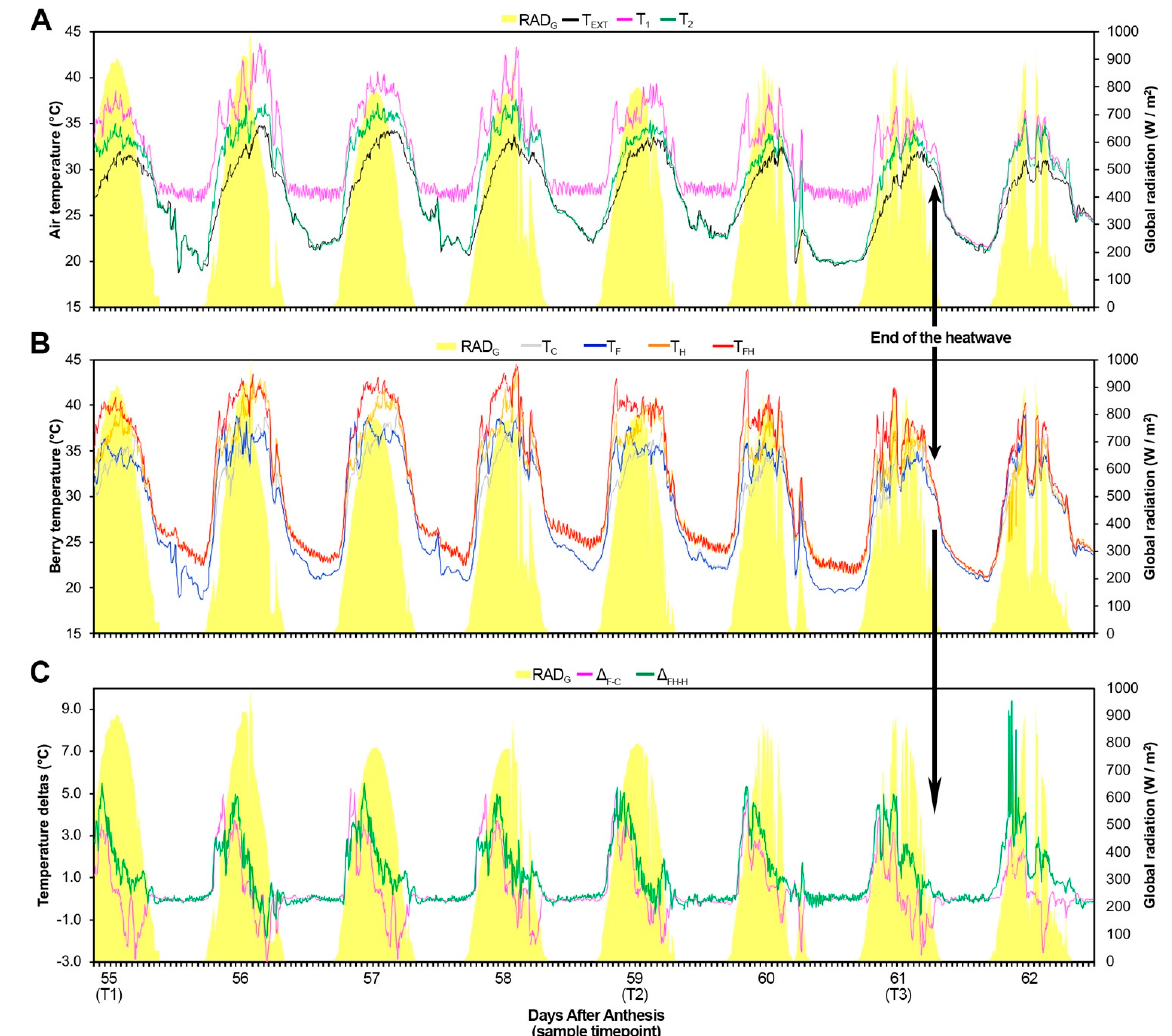
Figure 1. ( A ) Global radiation (RAD G ) and air temperature measured outdoor (T EXT ) at the site of the experiment (Legnaro, Padova, Italy; 45°20 ′ 58.8 ″ N 11°56 ′ 59.5 ″ E) and inside the tunnels used for the experiment (T 1 , Tunnel no.1; T 2 , Tunnel no.2). ( B ) Global radiation (RAD G ) and berry temperature (T C , control; T F , spring flooding; T H , summer heatwave; T FH , spring flooding + summer heatwave). ( C ) Differences (deltas) of the temperatures of F and FH berries with respect to their control C ( ∆ F—C ) and H ( ∆ FH—H ), respectively, are shown along with the global radiation to give an idea of the day- night rhythmicity. All parameters shown in both charts were measured from the beginning of the second phase of the heatwave when temperature increased (T1, 55 DAA) up to one day (62 DAA) after the end of the heatwave, as indicated by the black arrows. The small oscillations observed in the temperatures measured in Tunnel no.1 were due to the histeresis of the thermostat that controlled the heating